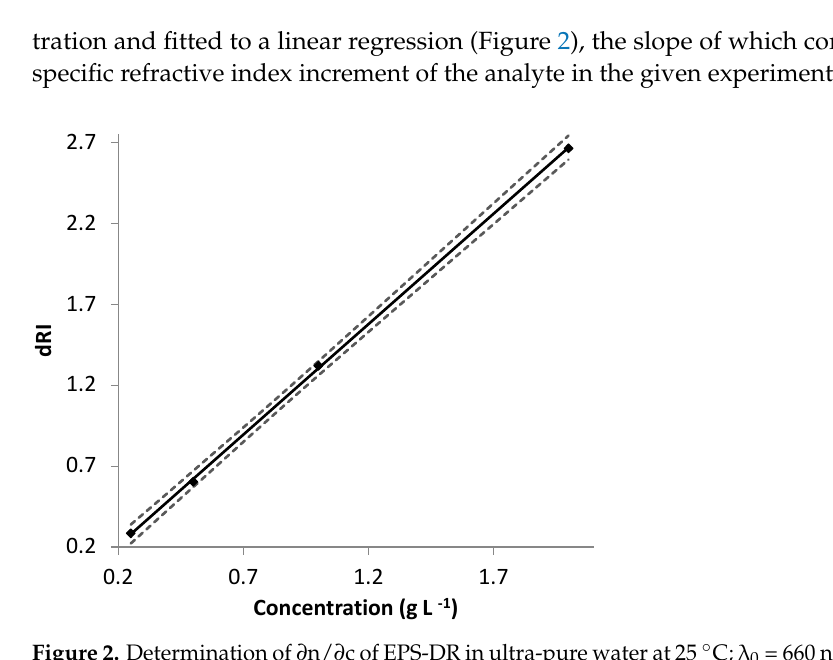
Figure 2. Determination of ∂ n/ ∂ c of EPS-DR in ultra-pure water at 25 ◦ C; λ 0 = 660 nm. Concentrations of EPS = 0.25 − 2 mg. mL − 1 . Measured differential refractive index dRI values (× 10 4 ) with EPS-DR concentration. The solid line represents the linear fit; the uncertainties’ hyperboles are plotted in dashed lines.